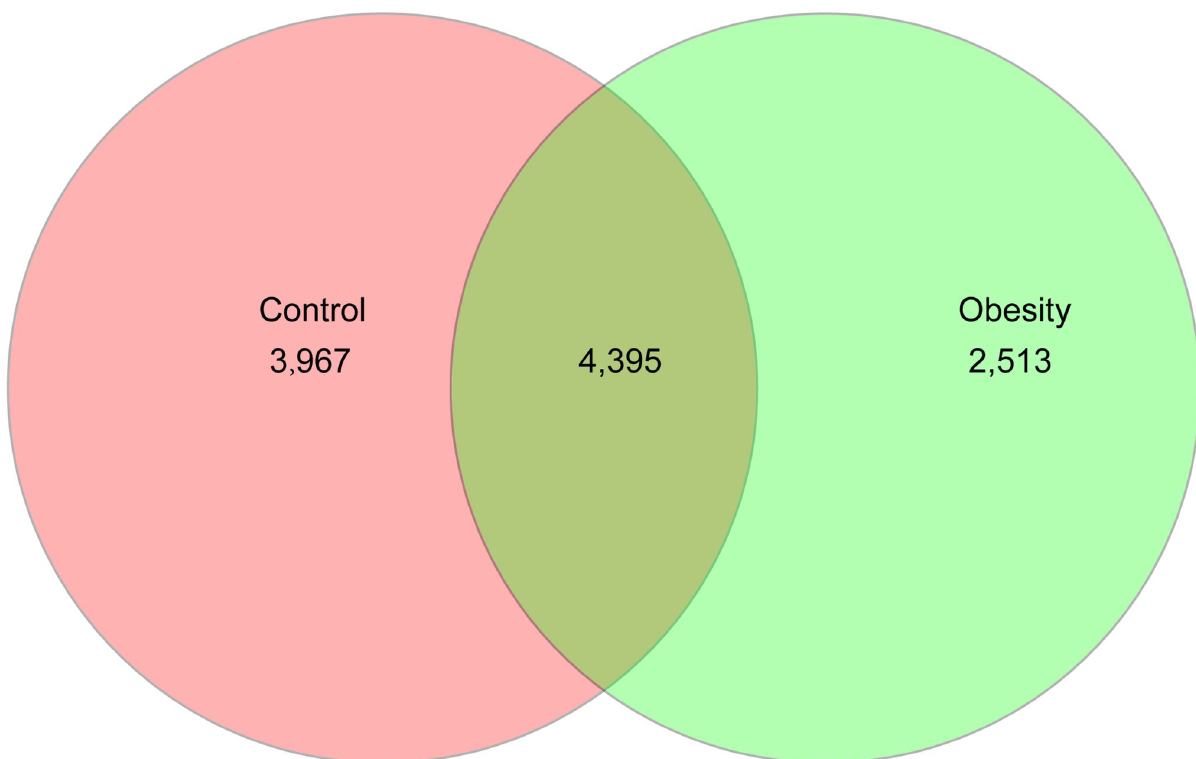
Fig 1. Venn chart illustrating the common and unique OTUs between Obesity and Control groups.